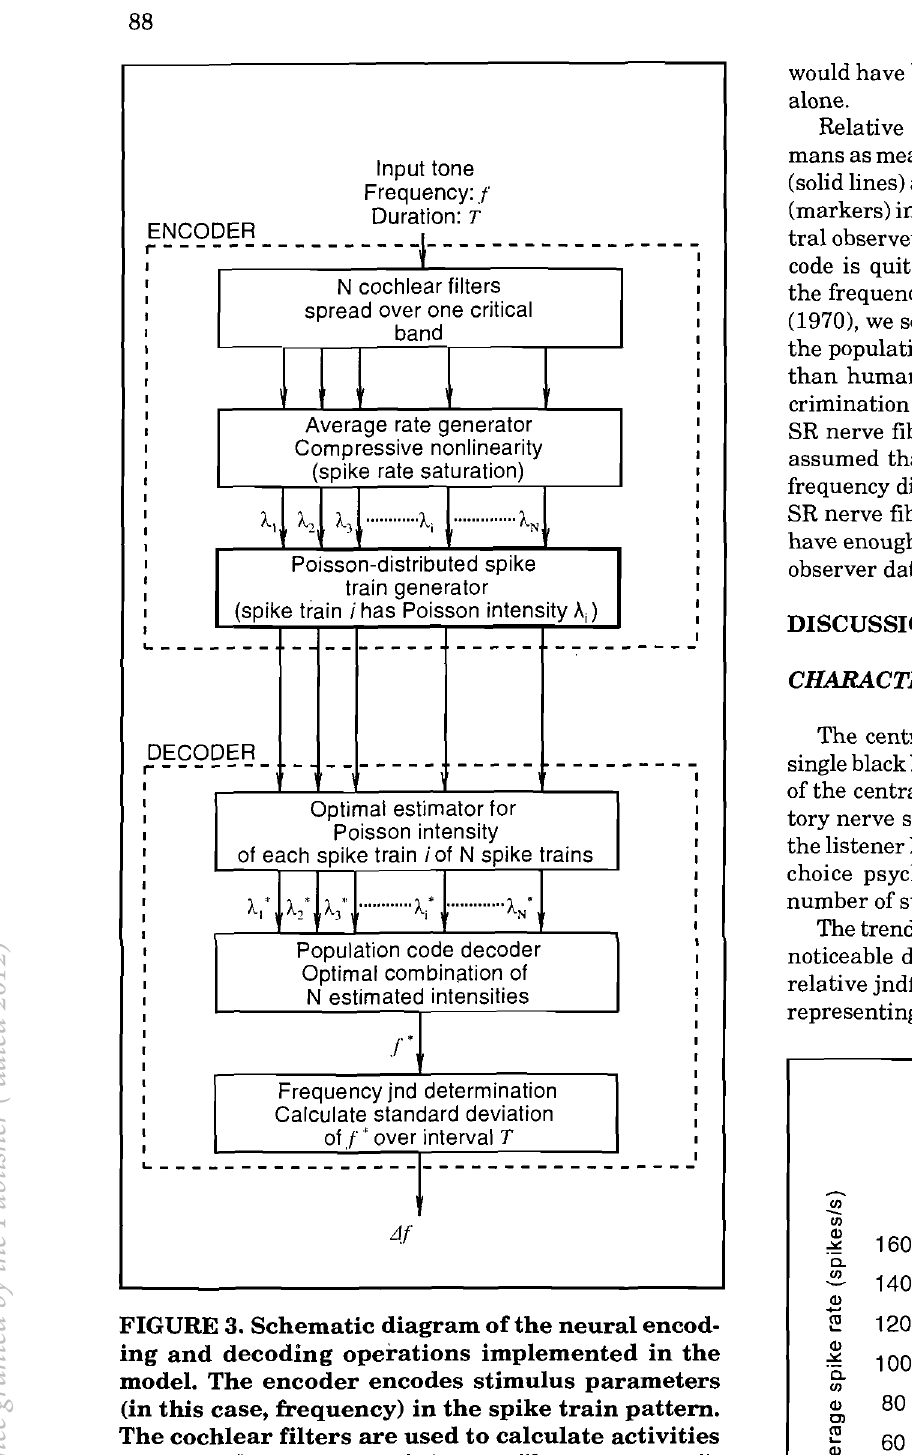
FIG URE 3. Schematic diagram of the neural encod ing and decoding operations implemented in the model. The encoder encodes stimulus parameters (in this case, frequency) in the spike train pattern. The cochlear filters are used to calculate activities of a neural population ofN nerve fibres (e.g., 150 fi bres) (centred approximately at the input tone fre quency) in response to the input tone. The amount of activation of each cochlear filter is then used to calculate the appropriate average spike rate for each fibre, using parameters for low spontaneous rate fibres and taking spike rate saturation into account. The N spike trains now carry the neural code for the input frequency. The spike rate (Poisson process intensity) is estimated separately for each spike train. These estimations are then combined to provide an estimate for the input frequency. The frequency jnd is determined by equating it to the standard deviation in estimated frequency over the duration of the stimulus.